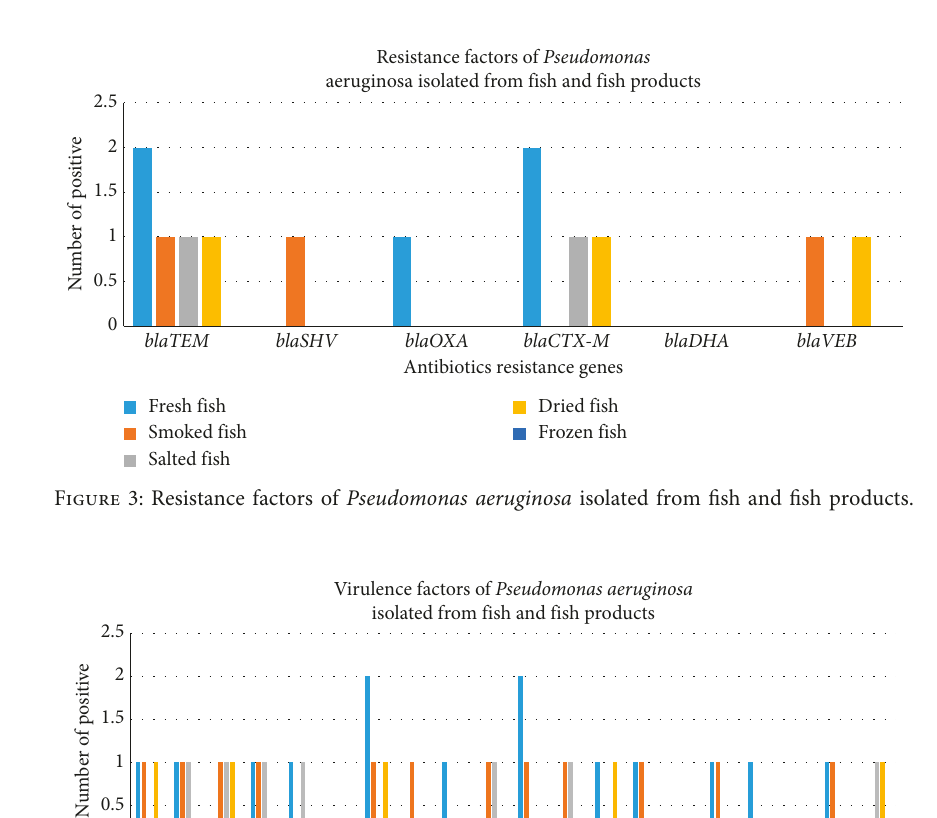
Figure 2: The number of isolates of antibiotic resistance pattern of Pseudomonas aeruginosa isolates isolated from fish and fish products..